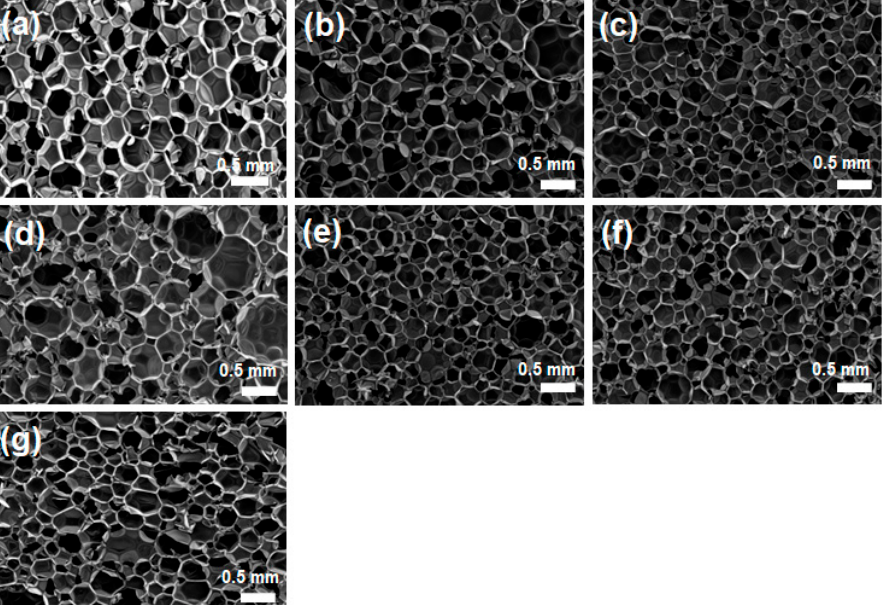
Figure 3. SEM images of neat PU foam without additive ( a ) and PU composite foams with silica aerogels without surface modification at different aerogel compositions of ( b ) 1 wt%, ( c ) 3 wt%, and ( d ) 5 wt%, and with silica aerogels with surface-modified silica aerogels of ( e ) 1 wt%, ( f ) 3 wt%, and ( g ) 5 wt%.